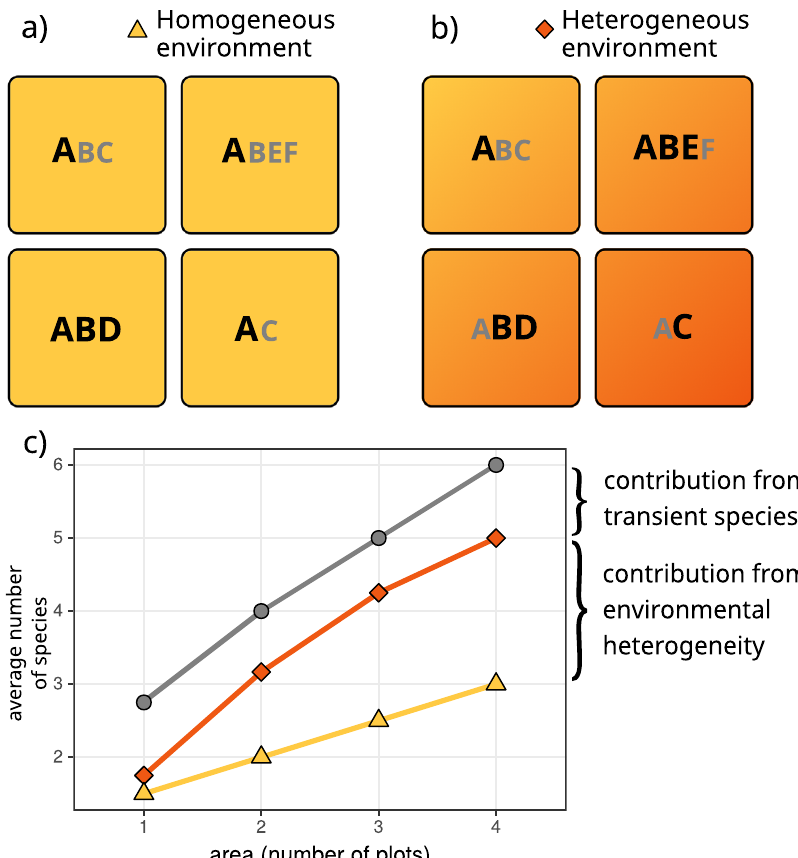
Fig. 1 A schematic dissection of species – area relationships (SARs) and their relation to species persistence in homogeneous and heterogeneous environments. In panels ( a , b ), each square represents a sampling area, and letters represent species observed in that area. In ( a ) we assume species experience the environment in a homogeneous way, meaning that their intrinsic growth rates and direct and indirect interactions do not change across squares. In ( b ) we consider that species are sensitive to changes in environmental heterogeneity to the extent that it promotes variation in both intrinsic growth rates and their network of interactions across the sampling area. Coexisting species are represented by bold letters, and transient species by smaller gray letters. In ( c ), we show the corresponding coexistence – area relationships for both environments, and the SAR. Variation among these curves can be ascribed to environmental heterogeneity (orange-yellow curves) and the prevalence of transient species (gray-orange curves) in the system. Finally, note that SARs are built by taking the average of all combinations of plots for a given area (i.e., a “ Type B ” relationship 43 ), thus resulting in non-integer values at intermediate areas.